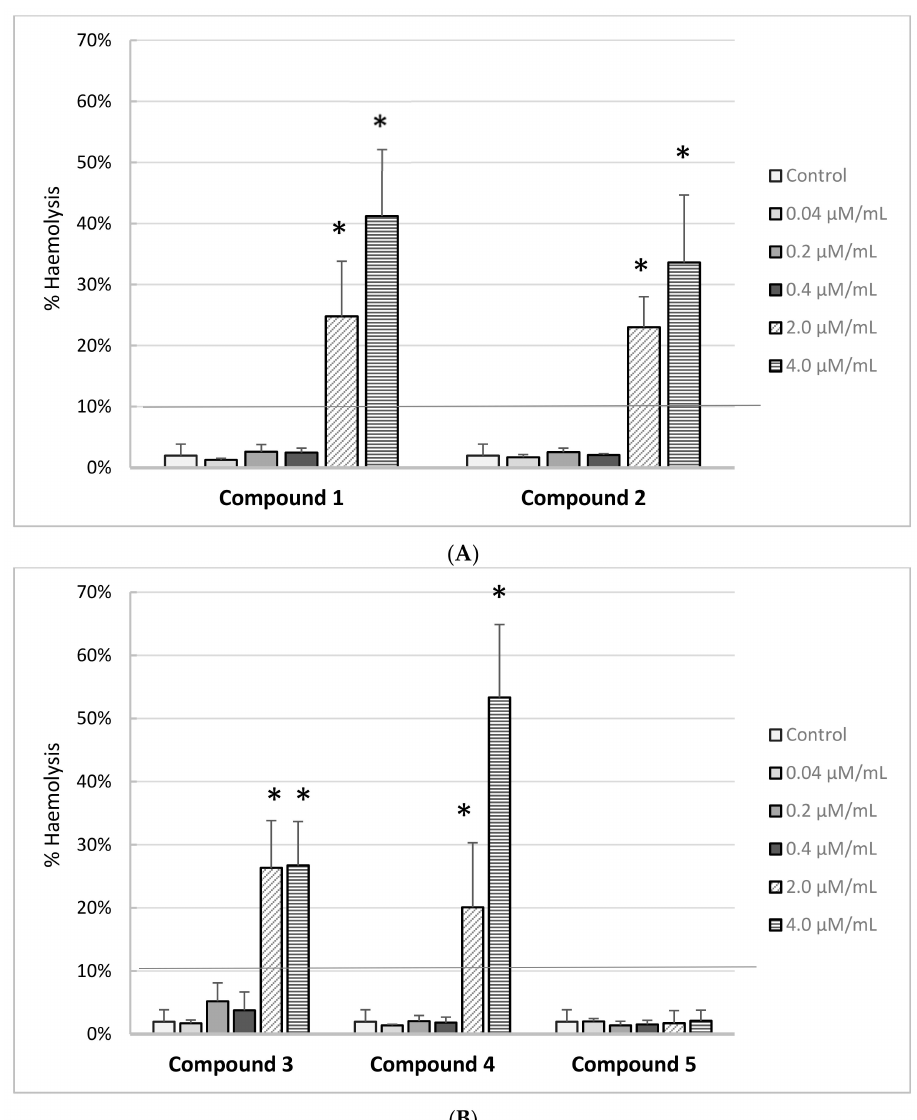
Figure 7. Percentage of haemolysis obtained from the interaction of iminodiacetic acid derivatives ( A ) compounds 1 and 2 ; ( B ) compounds 3 – 5 with 2% RBCs (red blood cells) suspension, compared to the positive control Triton X-100 at 0.2% (100% hemolysis) (mean ± SD; n = 5), * p < 0.05 vs. control. All newly synthesized compounds showed no adverse effect on the membrane of RBCs in the concentration range 0.04–0.4 µ mol/mL. A statistically significant increase in the rate of haemolysis was documented for the highest concentrations of compounds 1 – 4